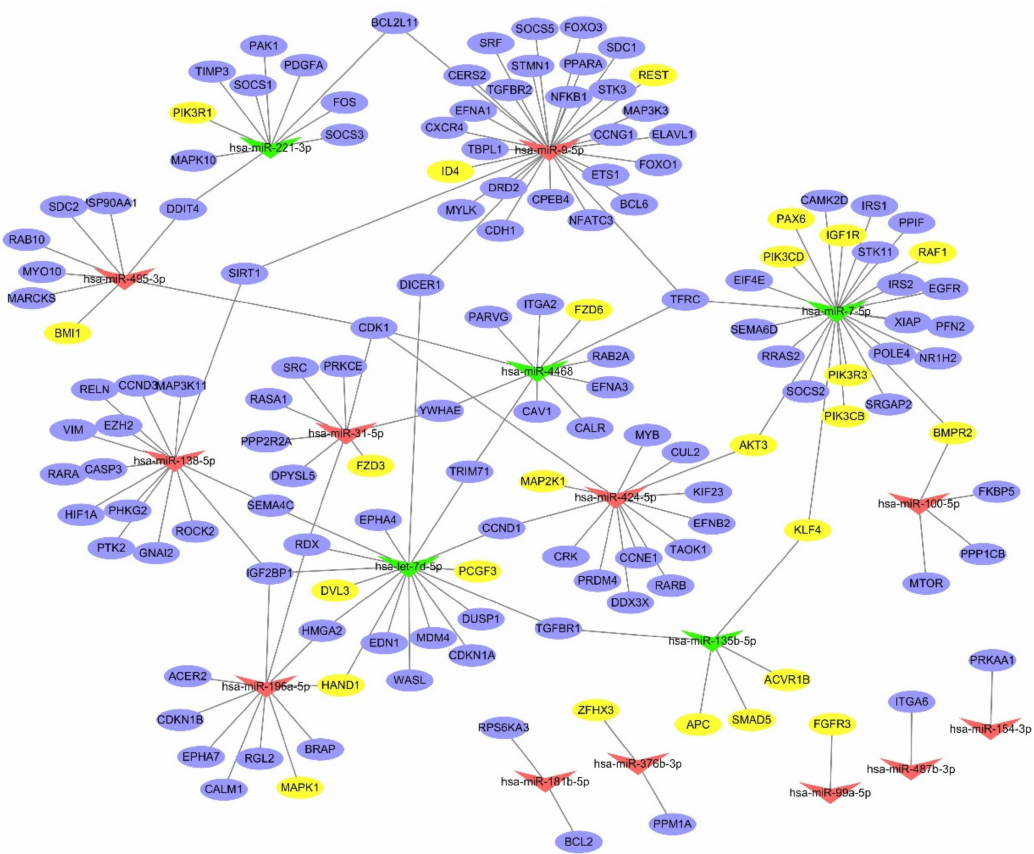
Figure 3. The regulatory network for di ff erentially expressed miRNAs. The purple nodes represent the target genes. The yellow nodes represent those were enriched in the signaling pathways regulating the pluripotency of stem cells. The red triangles indicate the up-regulated miRNAs, while the green triangles indicate the down-regulated miRNAs. The lines show the potential regulatory relationships between the miRNAs and target